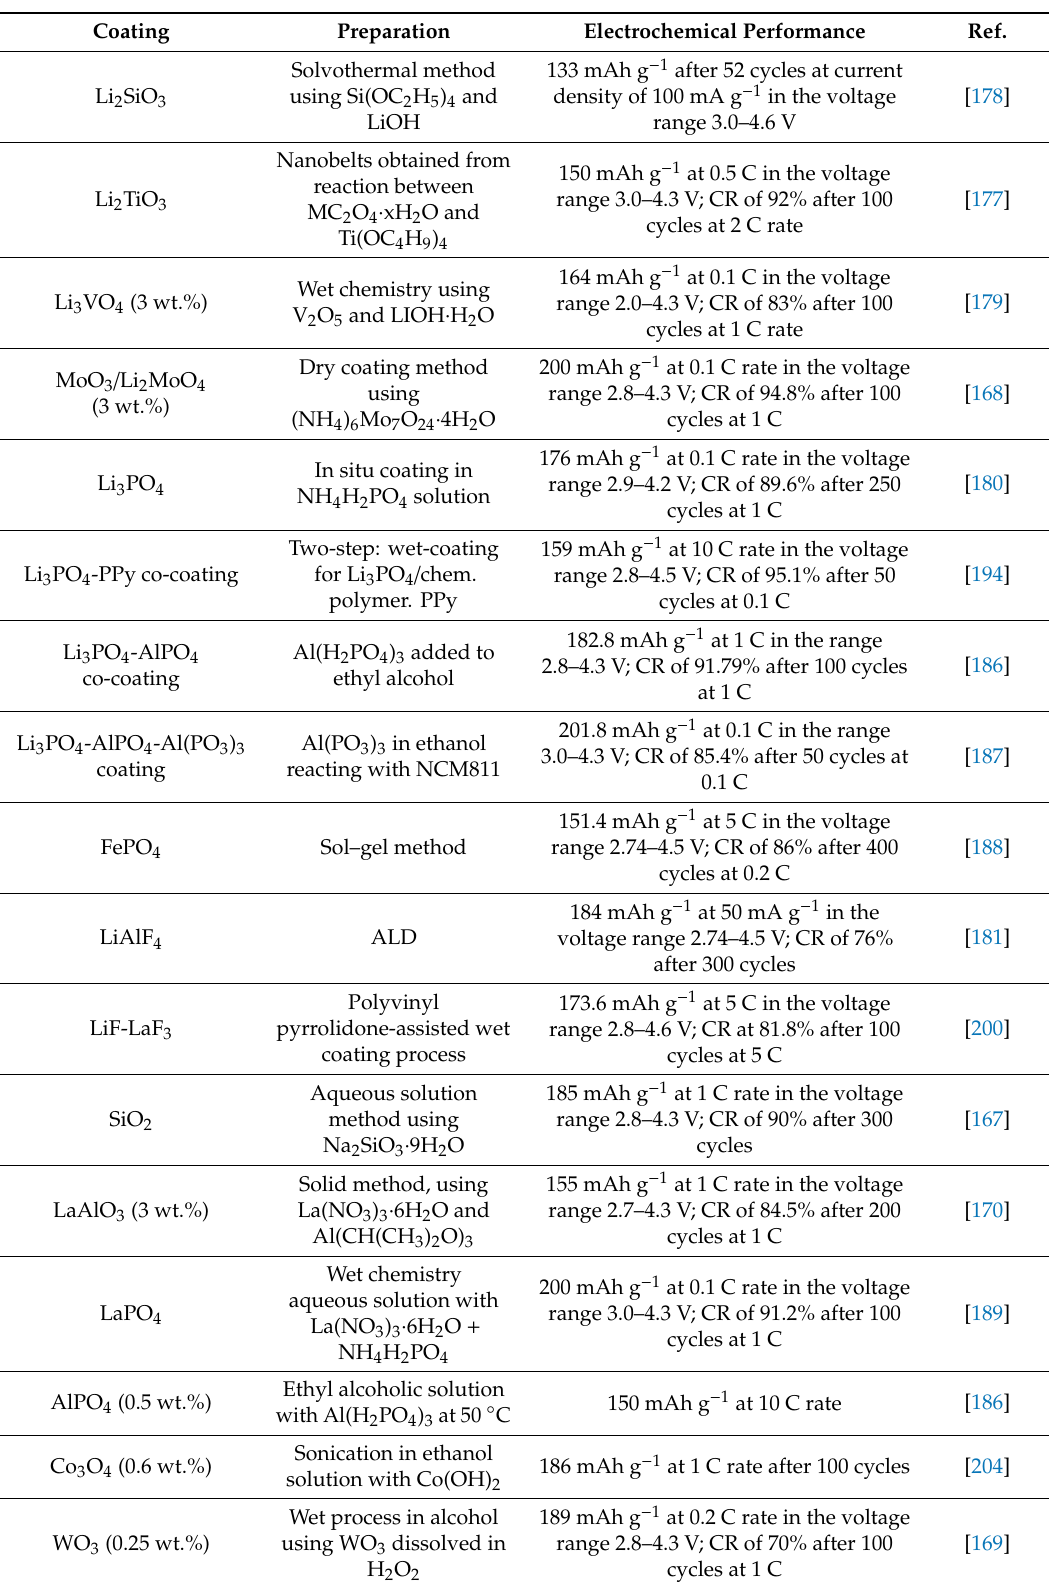
Table 3. Characteristics and electrochemical performance of NCM811 electrodes coated with various substances (CR = capacity